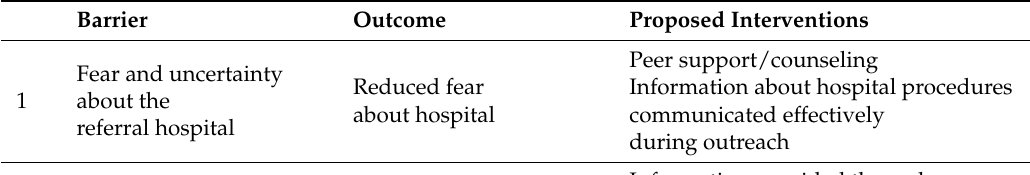
Table 2. Outcomes of theory of change